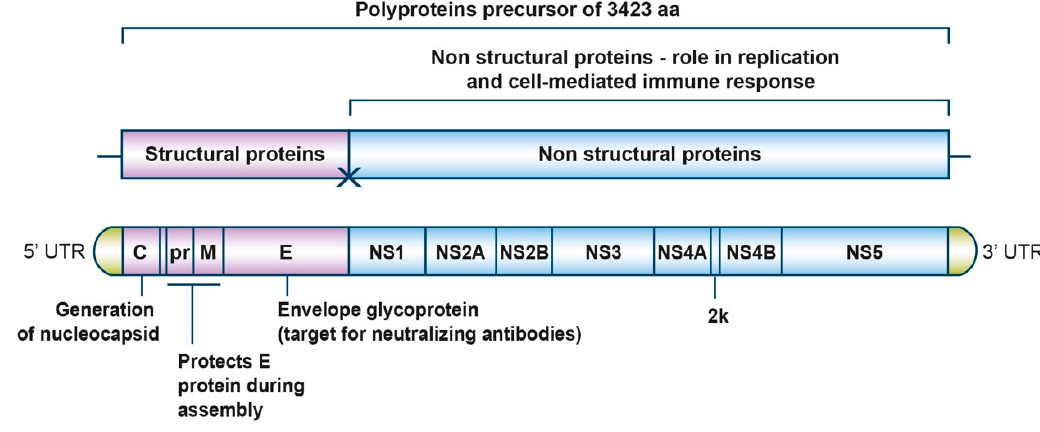
Figure 1. Detailed structure of Zika virus (ZIKV) genome. ZIKV genomic RNA is capped but lacks poly A tail. The viral RNA codes for a polyprotein that is co-translationally cleaved to yield 11 proteins: three structural proteins (C prM / M and E) and eight non-structural proteins (NS1, NS2A, NS2B, NS3, NS4A, 2K, NS4B, and